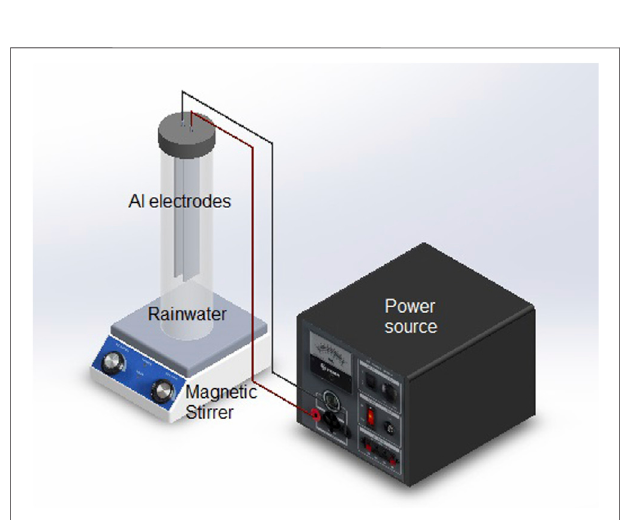
FIGURE 2 | Schematic view of experimental